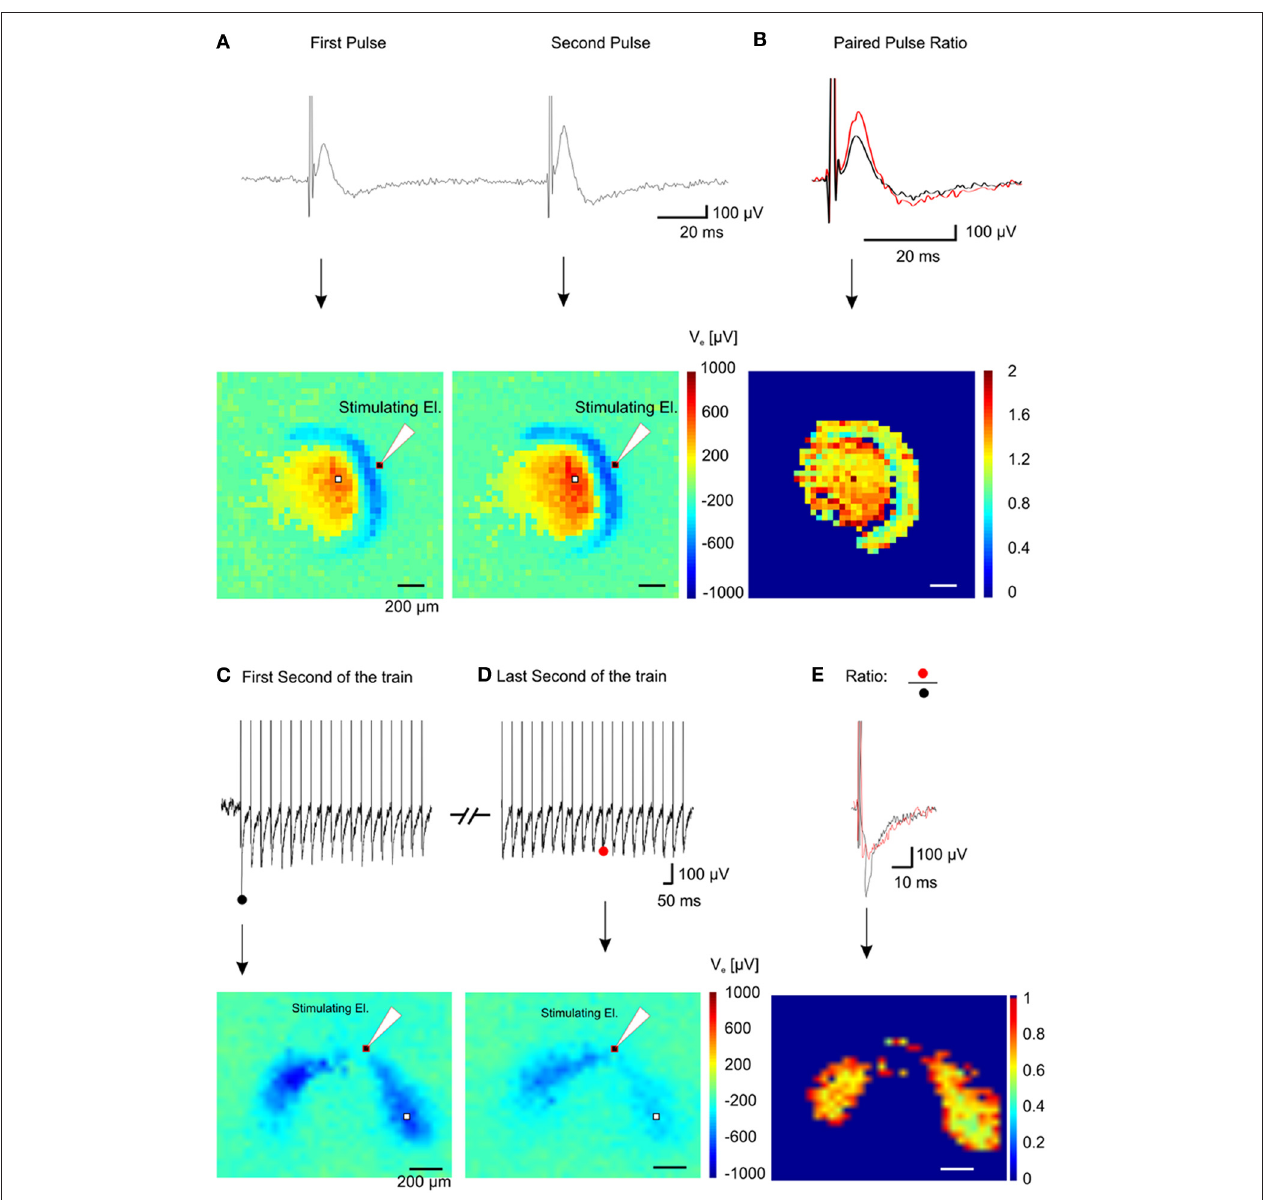
FIGURE 9 | Spatial short-term plasticity in the dentate gyrus. (A) Two fEPSPs recorded from a single electrode (white pixel) after a paired stimulation of the lateral perforant path ( (cid:2) t = 100ms) (top trace) and the relative color-coded map of maximum values for the pixel array showing activation of the dentate gyrus and hilus (bottom pictures). (B) Superimposition of the first and the second fEPSP shown in (A) (top trace) and color-coded spatial distribution of the ratio values recorded in the array (bottom picture). (C) Electrical response from one electrode (white pixel